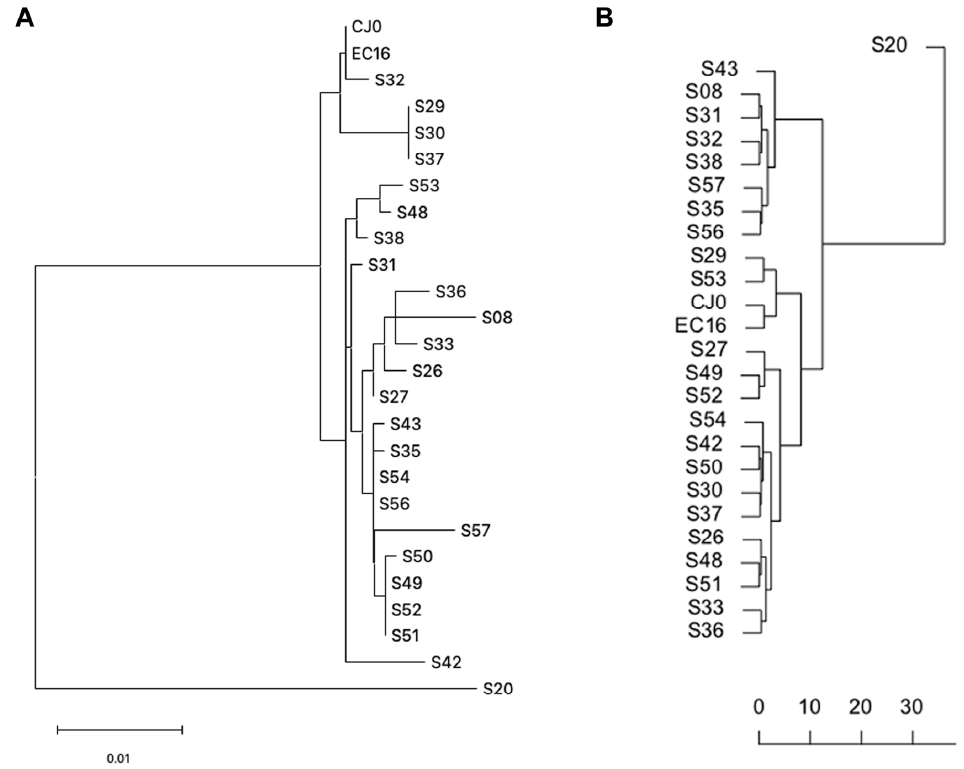
Figure 5. Dendrogram representation of consensus distances and δ -diversity values, hierarchical clustering. ( A ) Distance based dendrogram (MEGA 11); ( B ) δ -diversity based dendrogram (PVClust).